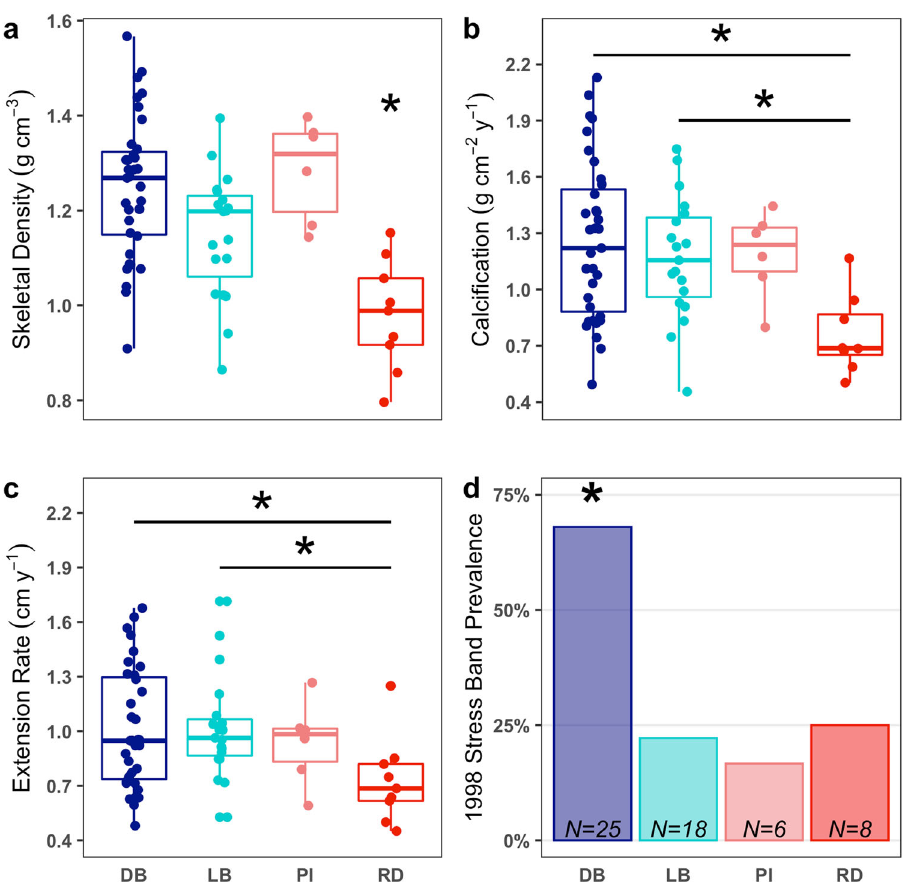
Fig. 4 Growth and thermal tolerance of corals from different lineages based on analysis of individual coral cores. In a – c , line segments and asterisks denote statistically signi fi cant differences ( p < 0.05) between groups based on post hoc Tukey tests. An asterisk over a single group denotes that group is signi fi cantly different from all others. a Boxplots of mean skeletal density of samples from each lineage. The Red (RD) lineage had lower skeletal density than all other lineages (ANOVA, F = 10.73, df = 3, p < 0.001). b Boxplots of mean calci fi cation rate of samples from each lineage. RD showed lower calci fi cation rates than the DB and LB lineages (ANOVA, F = 5.36, df = 3, p < 0.05). c Boxplots of mean extension rate of samples from each lineage. RD showed lower extension rates than the DB and LB lineages (ANOVA, F = 2.97, df = 3, p < 0.05). d Stress band prevalence by lineage in 1998. Proportion of stress differed signi fi cantly among lineages with DB lineage showing higher prevalence than all other lineages ( X 2 = 12.349, df = 3, p value < 0.05). Note that N values in d are lower than in a – c as not all cores extended back to 1998 (see Methods for further